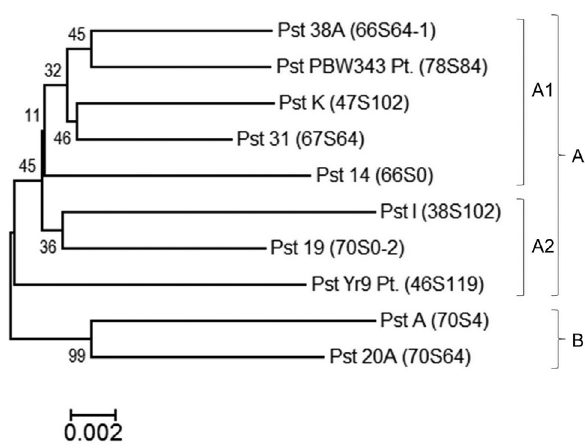
Figure 4 - Neighbor-joining tree based on combined nucleotide sequence of ITS, (cid:2) -tubulin , and ketopantoate reductase showing phylogenetic rela- tions among pathotypes of P. striiformis tritici